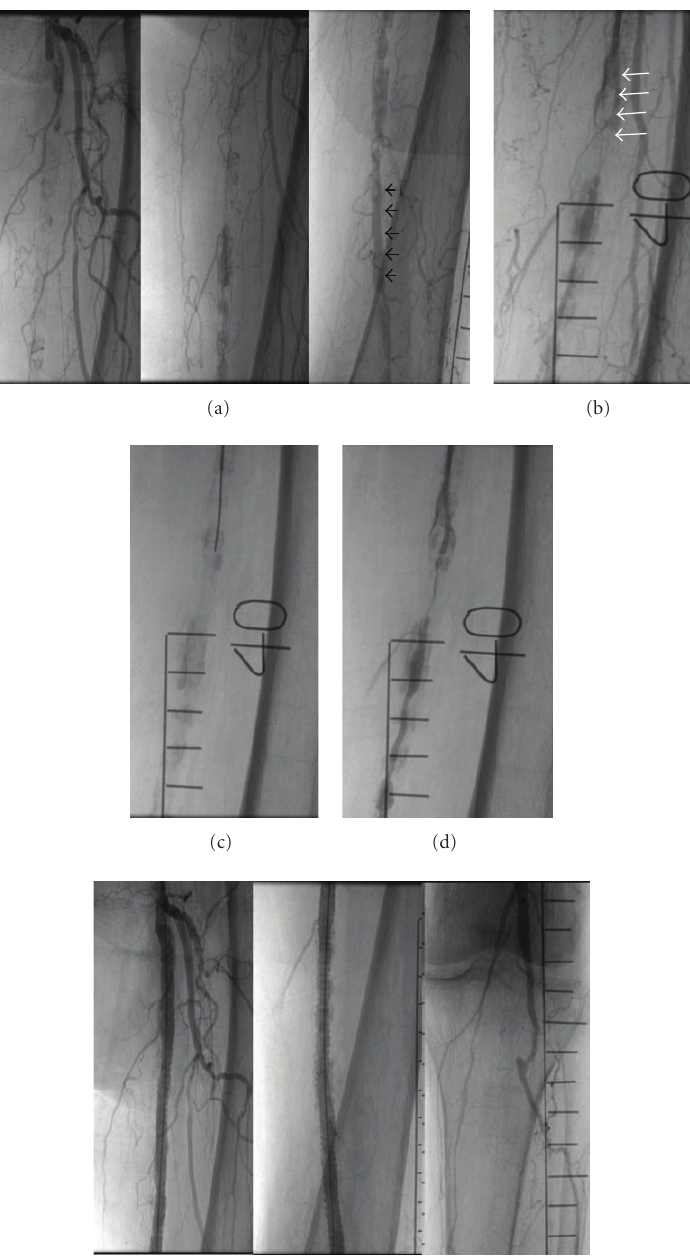
Figure 1: (a) Total occlusion of the superficial femoral artery (SFA) from the ostium onwards, heavily calcified plaques, and filling of the middle and distal portions of the SFA by collaterals is shown (black arrows). (b) A huge calcified plaque (white arrows) is noted in the proximal portion of the SFA, and this plaque impedes lesion crossing. (c) The sti ff end of the Terumo glidewire is used for sharp recanalization. (d) The middle portion of the SFA was observed using a contrast medium that was injected through the right Judkin catheter after sharp recanalization. (e) Stent implantation from the proximal to the distal portion of the SFA is successful, and good angiographic results are